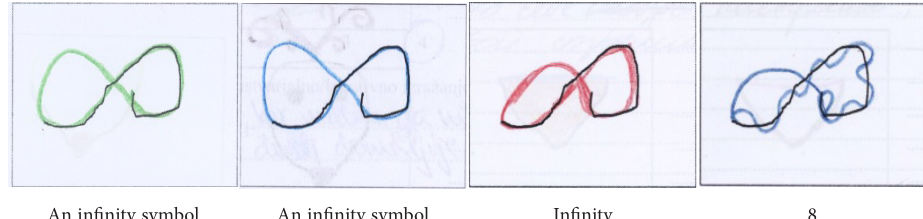
Figure 15. The creative task: interpretation of Fragment 2 – a symbol of infinity (source: testingmom.com,